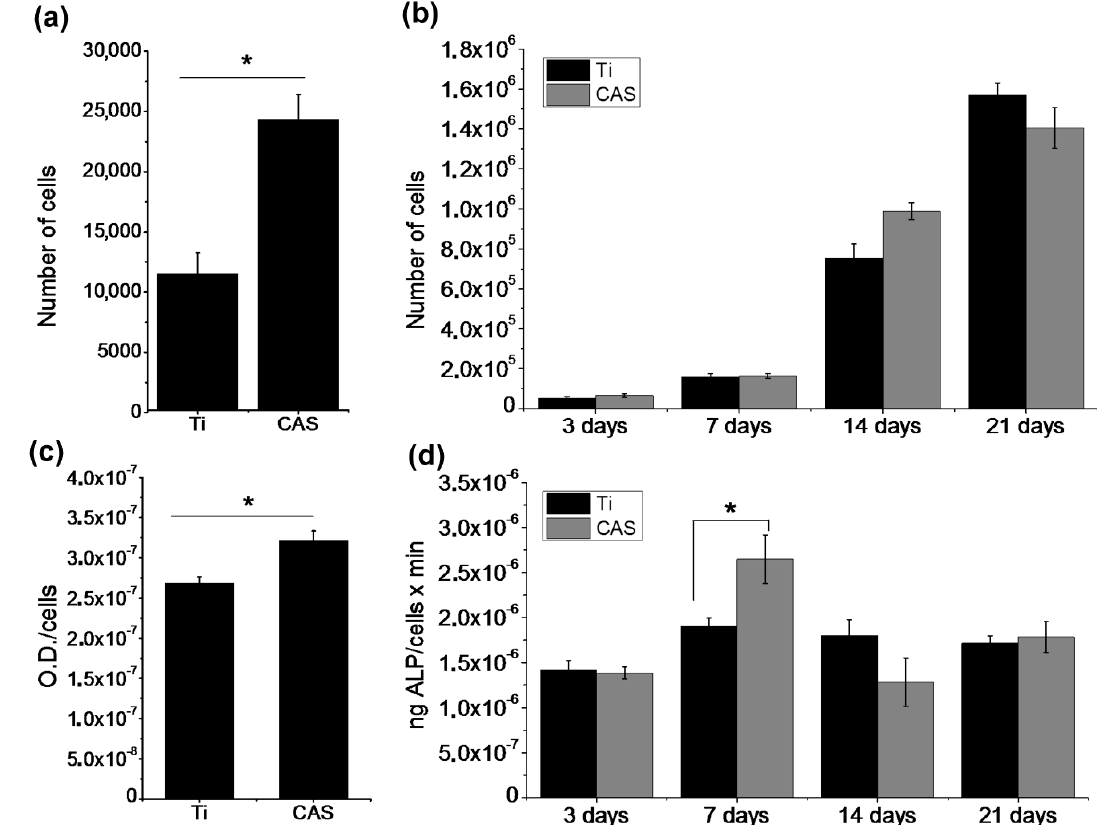
Figure 8. Cell behavior on CAS-functionalized and nonfunctionalized Ti scaffolds.( a ) Cell adhesion of SaOS-2 cells after 6 h of incubation and ( b ) cell proliferation after 3, 7, 14 and 21 days measured by LDH activity. ( c ) Mineralization after 21 days of incubation by Alizarin Red staining. O.D. stands for optical density. ( d ) Cell differentiation measured by ALP activity. At each time point, the symbol “*” means statistically significant differences between bare Ti and CAS-functionalized-Ti scaffolds ( p < 0.05).